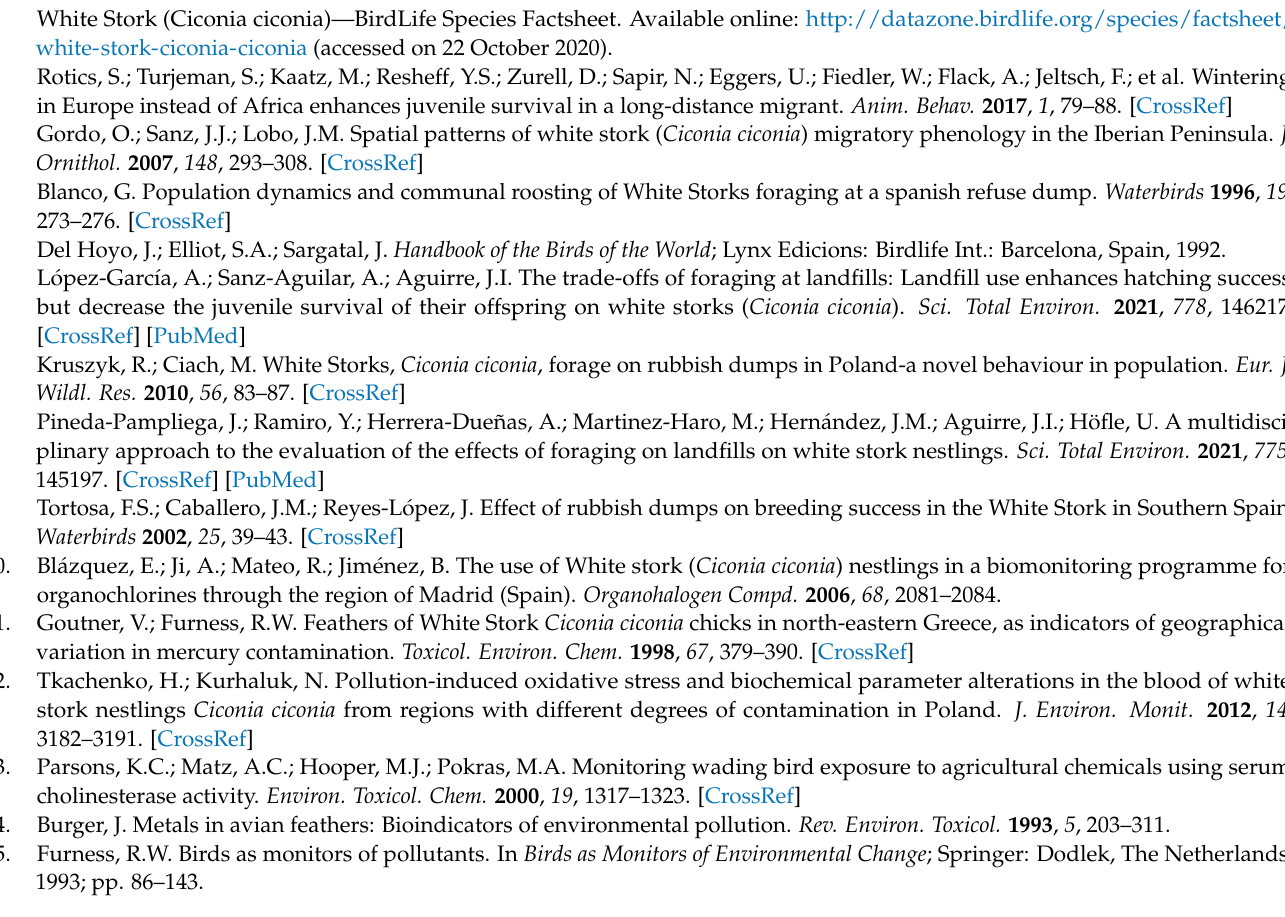
Figure S6. CellTracker TM Green CMFDA dye for GSH detection; Figure S7. CM-H 2 DCFDA dye for ROS